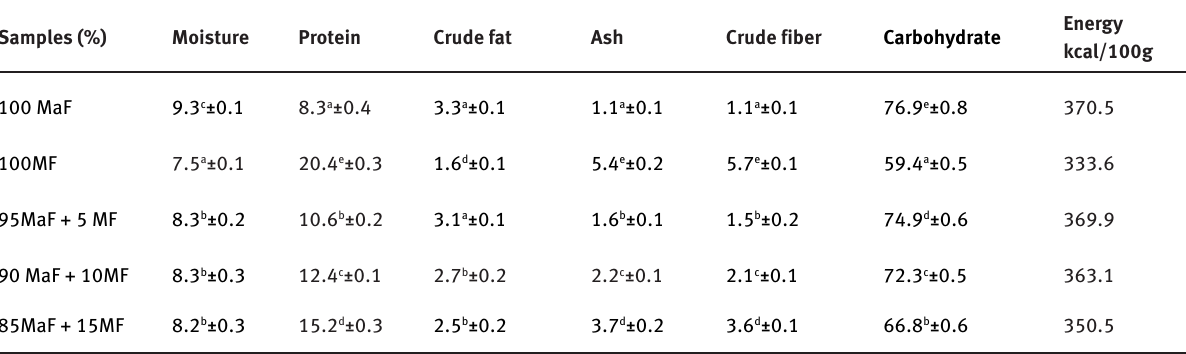
Table 1: Proximate composition of maize ( Zea mays ) flour composited with mushroom ( Pleurotus ostreatus ) flour at different ratio (%)